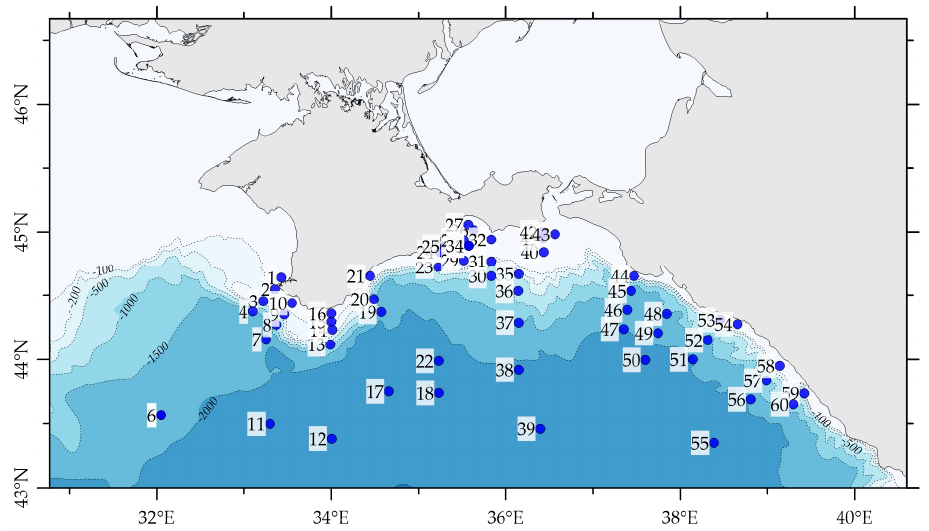
Figure 1. Sampling map for 226 Ra and 228 Ra activity definition during the 116 RV Professor Vodyanit- sky cruise (22 April–17 May, 2021).